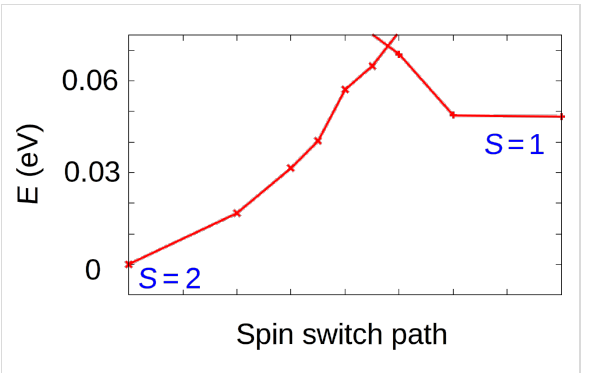
Figure 4: calculated activation barrier between HS (S = 2) and IS (S = 1) of a FeTPP molecule in C 2h conformation.